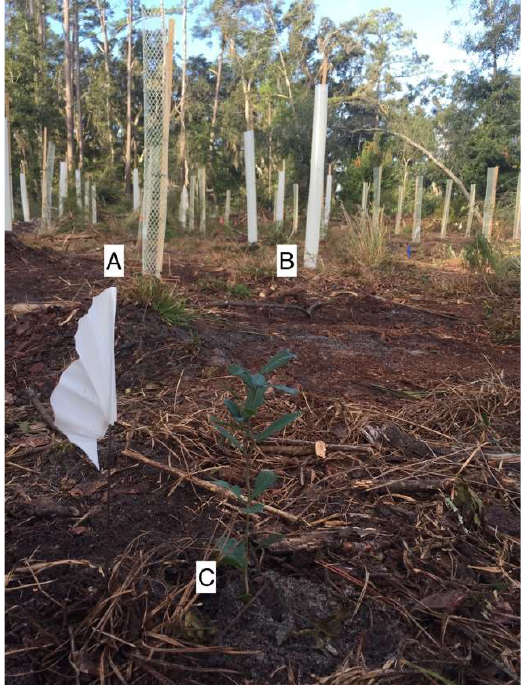
Figure 1. ( A ) mesh tree shelter, ( B ) solid-wall tube tree shelter with ventilation holes, and ( C ) seedling with no shelter, all at the time of planting (photo credit: E. Thyroff).